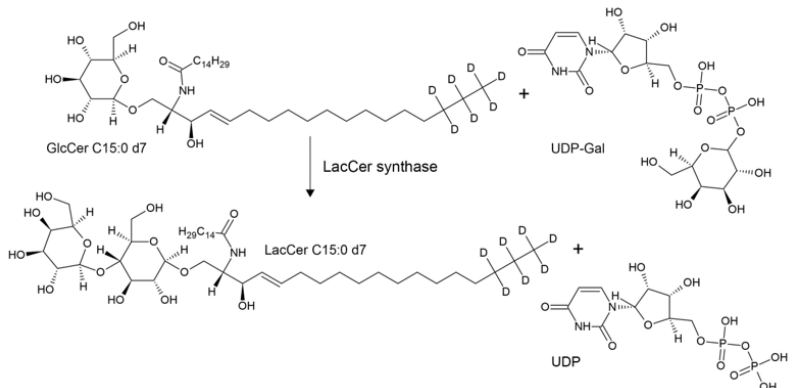
Figure 2. LacCer synthase catalyzed reaction. Acceptor substrate GlcCer is depicted as the deuterated molecular species used in the novel